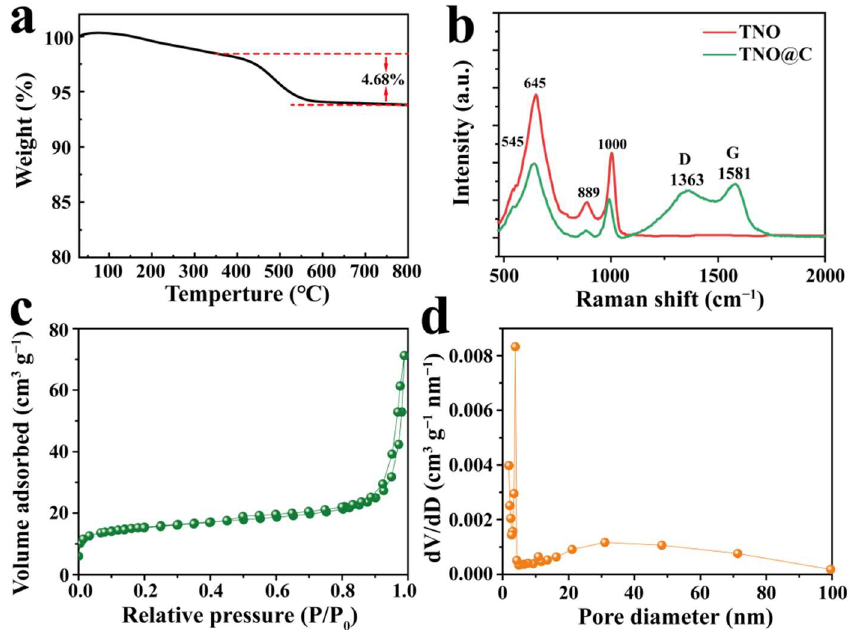
Figure 2. ( a ) TG curve of TNO@C analysis performed in air; ( b ) Raman spectra of TNO and TNO@C; ( c , d ) N 2 adsorption–desorption isotherm and pore-size-distribution curve of the TNO@C.